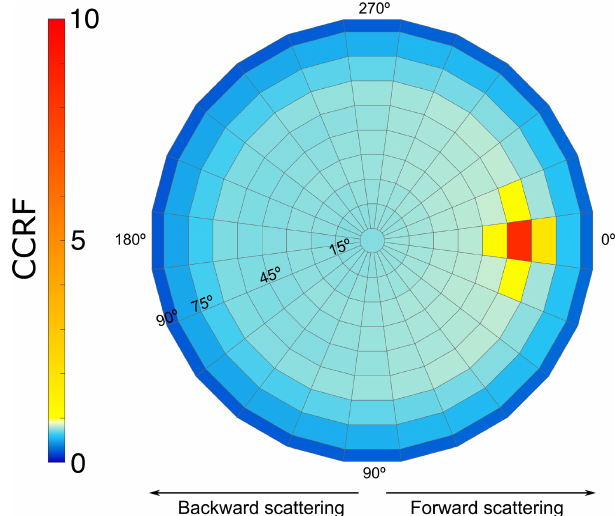
Figure 2. Polar plot of the CCRF of optically thick first-year sea ice, with a solar zenith angle of θ = 60 ◦ and a roughness param- eter of σ = 0 . 01. The solar azimuth angle φ i is located at 180 ◦ ; consequently, the left half of the hemisphere between φ = 90 ◦ and φ = 270 ◦ represents the backward-scattering component, and the right half of the hemisphere between φ = 270 ◦ and φ = 90 ◦ repre- sents the forward-scattering component. In this case, a strong spec- ular forward-scattering peak can be observed centred over the quad located at φ r = 0 ◦ and θ r = 60 ◦ . A nonlinear colour bar was used to capture the large values around the scattering peak whilst showing the pattern in the quasi-isotropic part of the